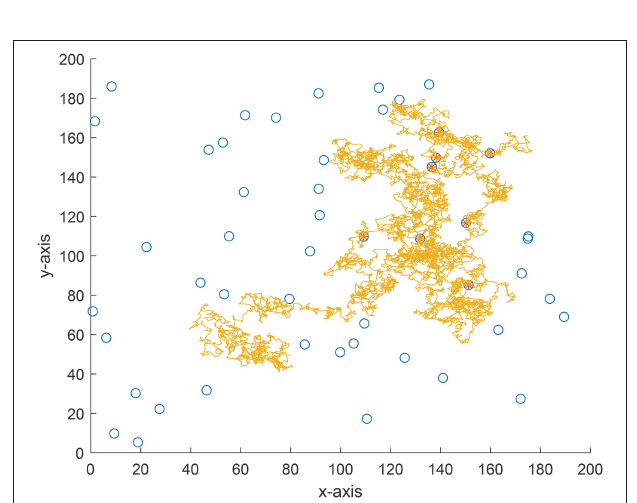
FIGURE 12 | The actual tempered Lévy density function with ρ = 0.5 and µ = 1 and the statistic results of generated jump